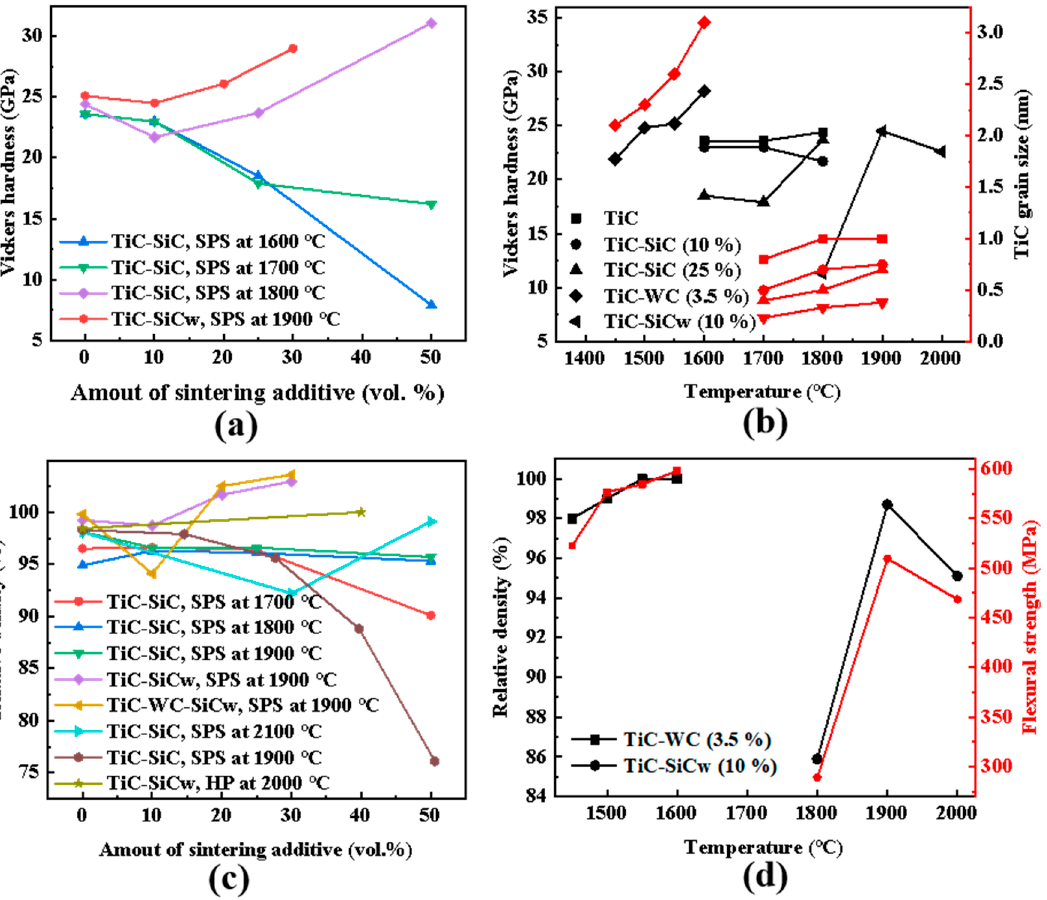
Figure 4. Effects of preparation process and carbide type on hardness and density of TiC-based composites. ( a ) Quantitative relationship between relative density and sintering additive dosage, ( b ) Vickers hardness and grain size of TiC based ceramics at different testing temperature, ( c ) Quantitative relationship between Vickers hardness and additive content, ( d ) Relative density and bending strength of TiC based ceramics at different testing temperature.